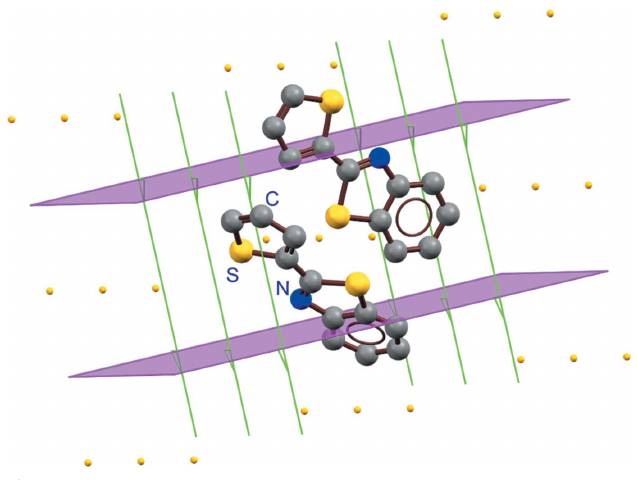
Figure 2 Mercury (Macrae et al. , 2020) rendering highlighting space-group symmetry elements of the Z 0 = 2 polymorph